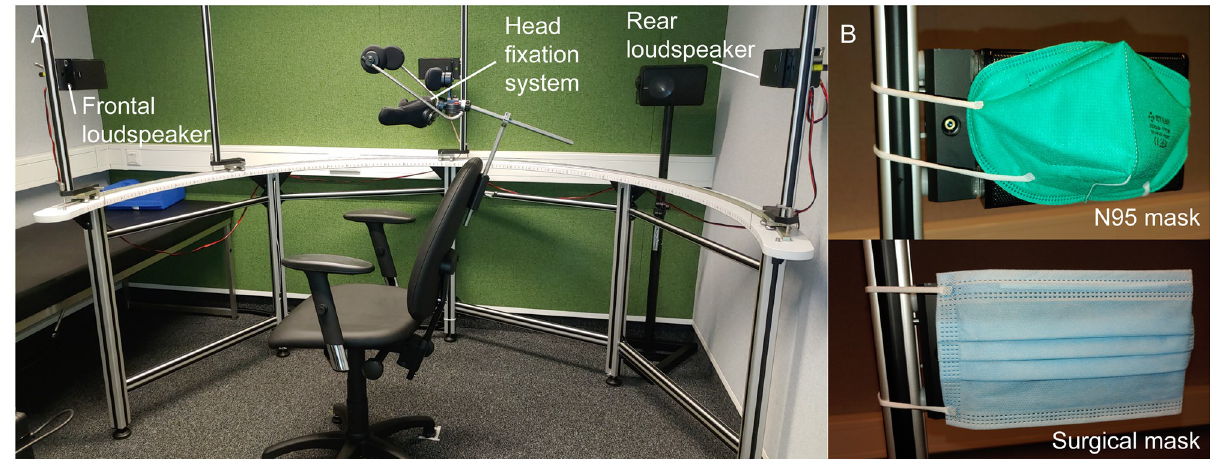
Fig 1. Experimental setup (A) and used face masks